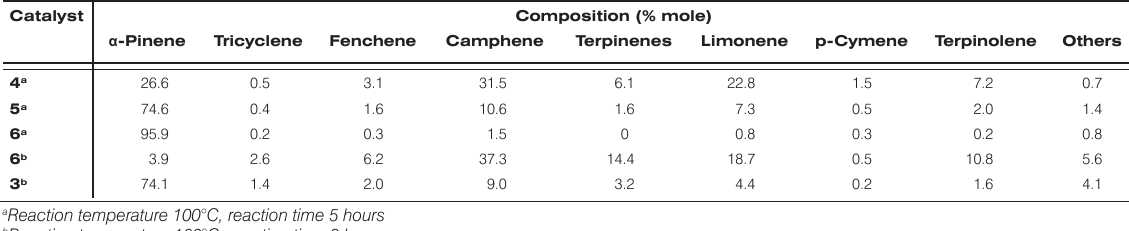
Table 3. Conversion of α -pinene and selectivity to camphene, limonene and terpinolene (20 g α -pinene, 0.2 g catalyst). Catalyst Reaction time (h) Conversion (%) Selectivity (%)